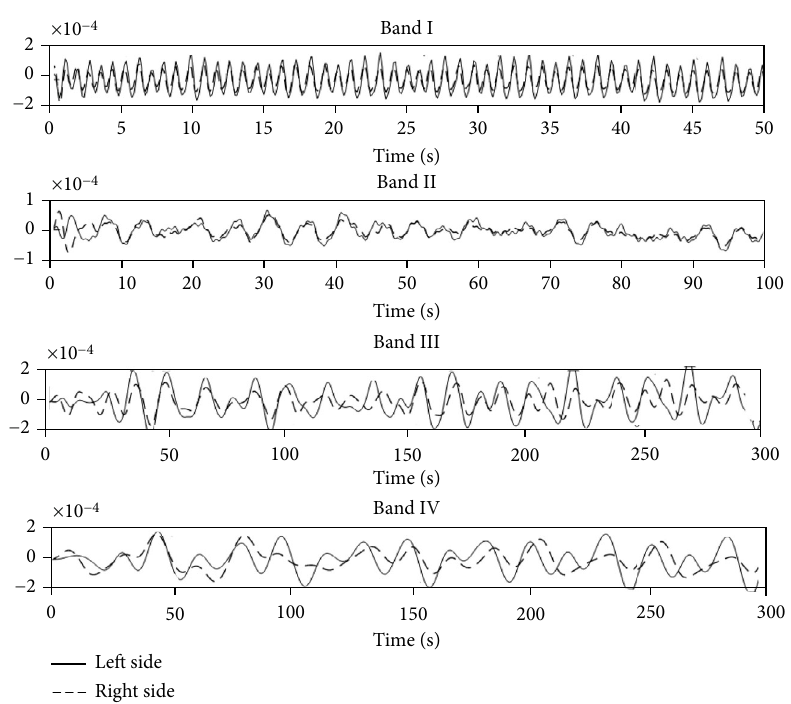
Figure 4: Representative resting-state IHCCs in the frequency bands I – IV in the SMC during Bi-cTBS/iTBS stimulation. (a – d) IHCCs from band I to IV, respectively. Solid line ( ̶ ) and dashed line ( – ) indicate HbO oscillation in the left and right hemispheres,